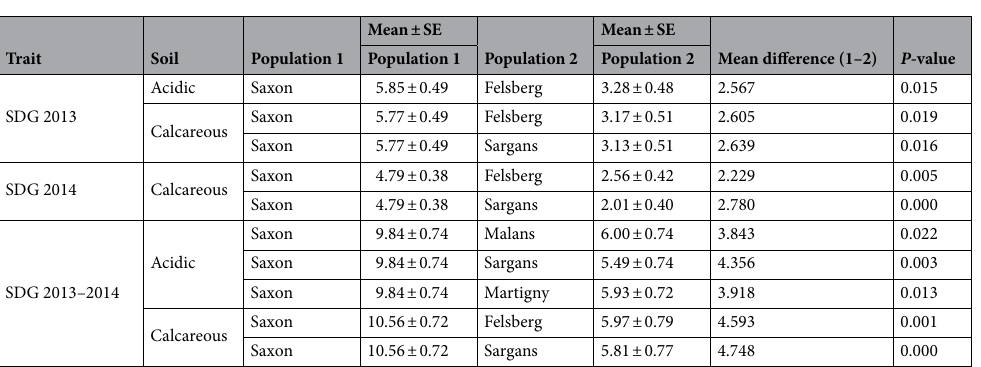
Table 1. Significant differences for the SDG traits between populations under drought treatment based on the t test for equality of means.